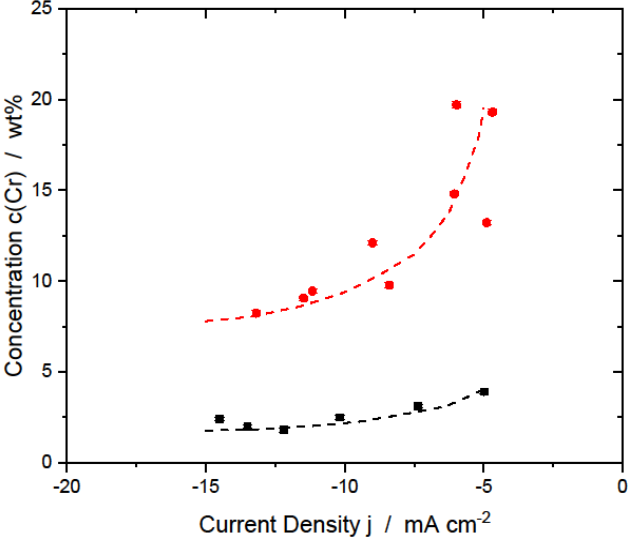
Figure 2. Cr content of the AlCr deposits (EDS) vs. current density for [EMIm]Al 2 Cl 7 –10Cr ( ■ ) and [EMIm]Al 2 Cl 7 –50Cr (●). The dashed lines are just for eye-guidance and have no physical meaning.